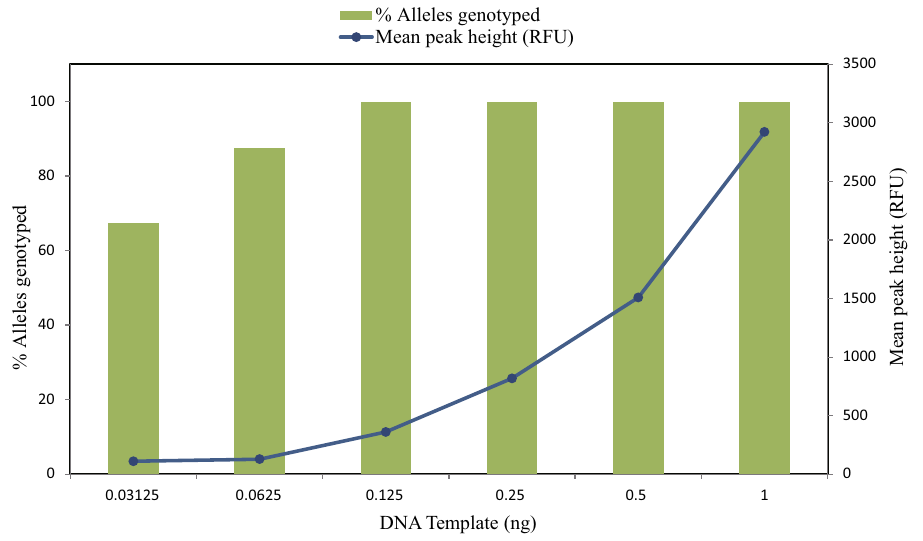
Figure 2. Sensitivity testing of control DNA F312 ranging from 1 ng to 31.25 pg. The left-hand y-axis indicates percentage of successfully genotyped alleles, while the right-hand y-axis indicates mean peak